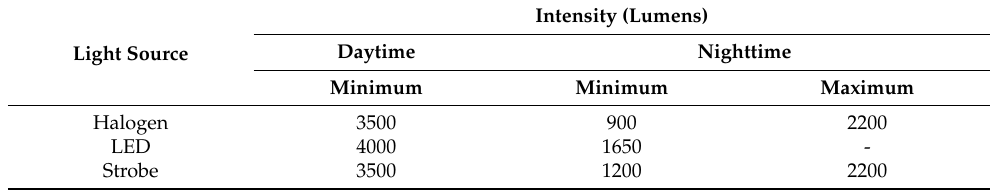
Table 7. AASHTO recommendations for daytime and nighttime intensities for various light sources